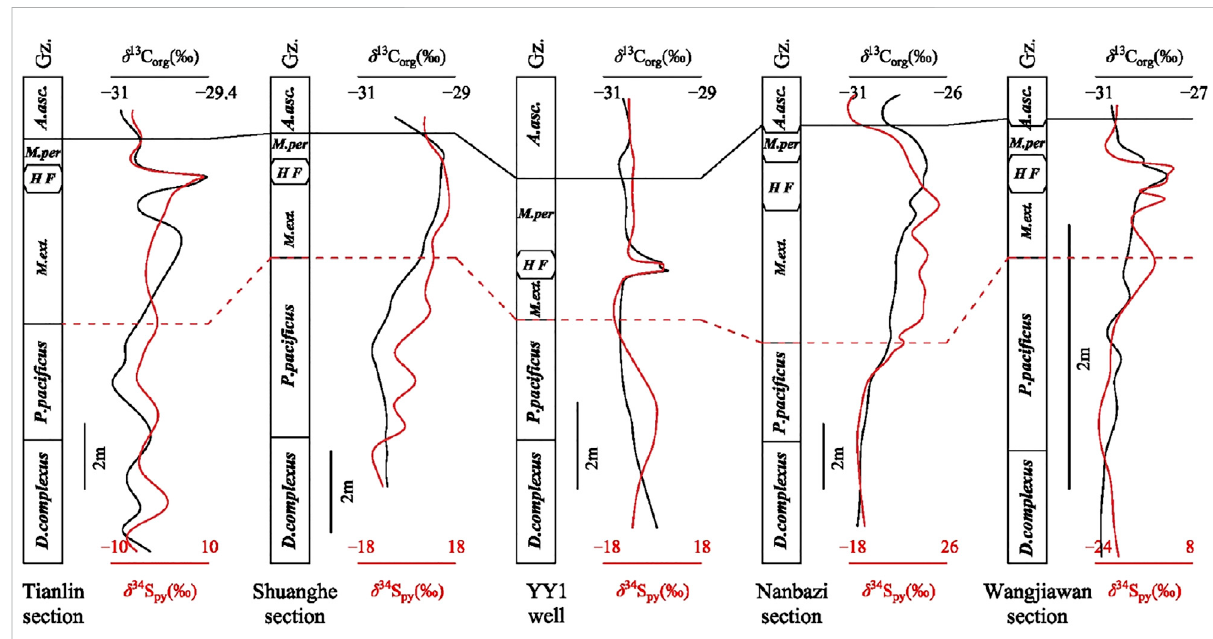
FIGURE 4 Stratigraphic correlation of δ 13 C org and δ 34 S py sections during the O-S period. Data of the Shuanghe section, YY1 well, Nanbazi section, and Wangjiawan section can be found in previous studies (Yan et al., 2009b, 2012; Liu et al., 2016; Li et al., 2017a; Li N et al., 2021; Li Y et al., 2021).